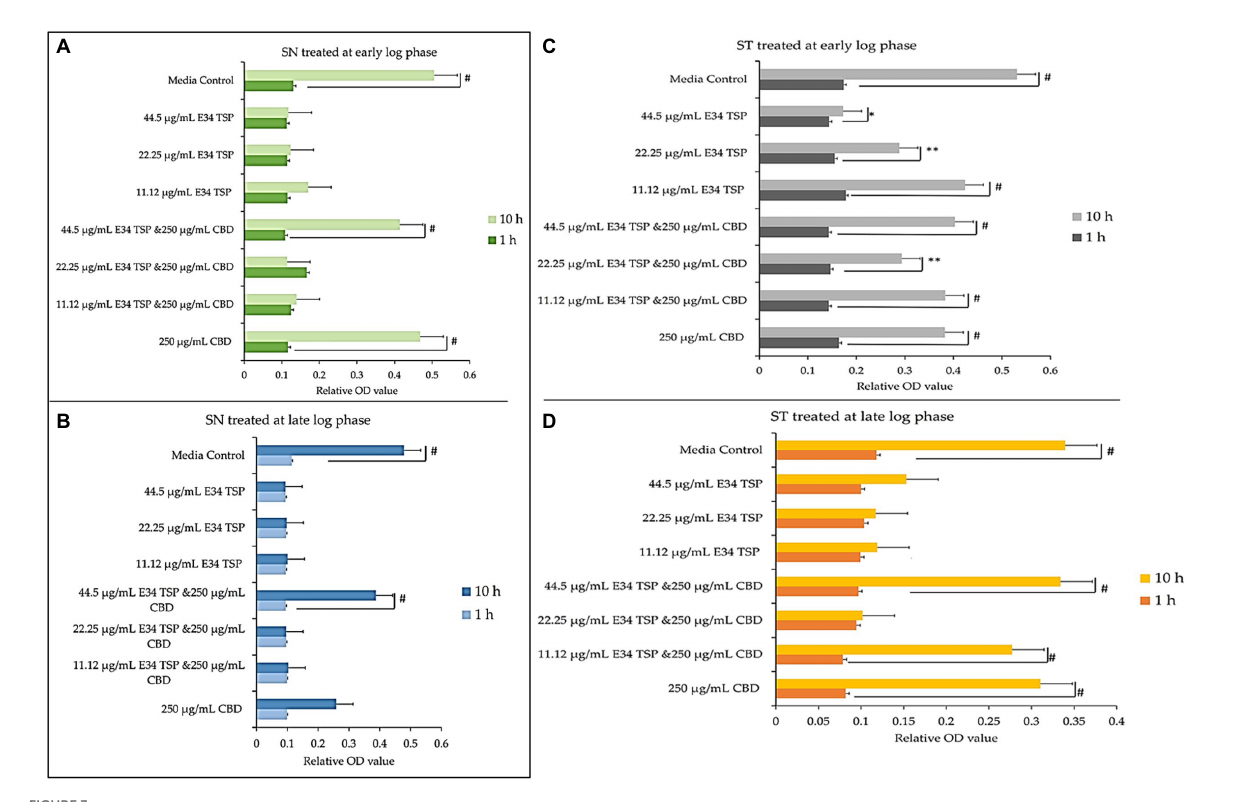
FIGURE 3 (A,B) Effect of CBD extract /E34 TSP treatment of S . Newington in both early and late log phase of the bacteria species. Studies were initiated an initial OD 600 of approximately 0.1. (A) CBD extract and E34 TSP treatment to S . Newington (SN) at early log phase. # value of p ≤ 0.00354. (B) CBD extract and E34 TSP treatment to S . Newington (SN) at late log phase. Data shown are from three independent experiments expressed as means ± SEM. # value of p ≤ 0.039. (C,D) Effect of CBD extract and E34 TSP treatment of S . Typhimurium in both early and late log phase of the bacteria species. (C) CBD extract and E34 TSP treatment to S . Typhimurium (ST) at early log phase. # value of p ≤ 0.0001, * and ** value of p ≤ 0.025. (D) CBD extract and E34